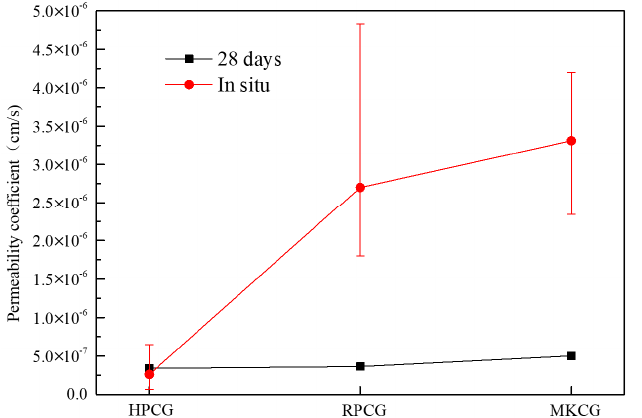
Figure 21. Comparison of permeability coefficients of in situ tests with laboratory tests at 28 days.